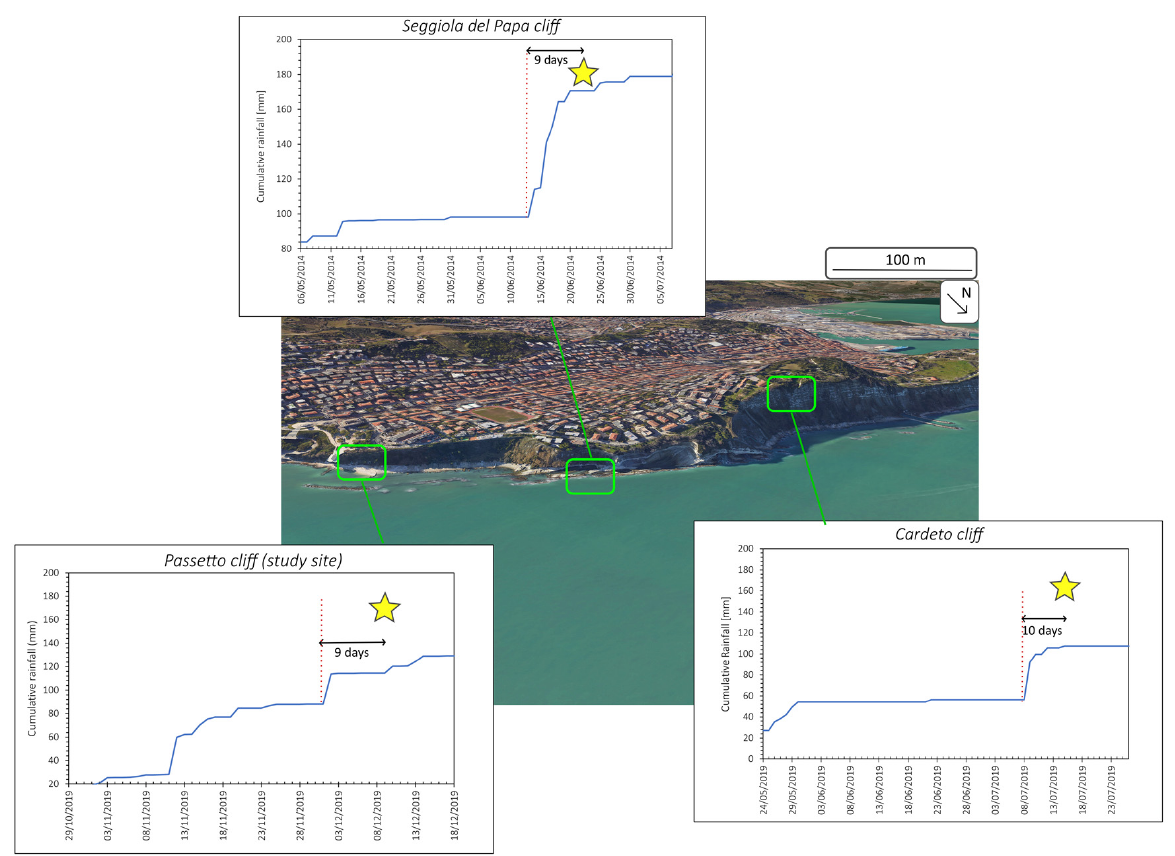
Figure 11. Relation between rockfall events in the coastal area of Ancona and cumulative rainfall. The location of three events recorded between 2014 and 2019 involving the Schlier Fm. near the analysed area (Passetto cliff) are reported.